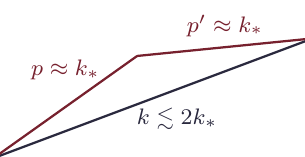
Figure 8 . By momentum conservation we must have k = p + p 0 where k is the momentum of GW and p and p 0 are momenta of dark photons. The main contribution of dark photons come from momenta p = p 0 = k ∗ which are significantly produced in tachyonic regime. As a result, the momentum of GW can be at most 2 k ∗ corresponding to a folded